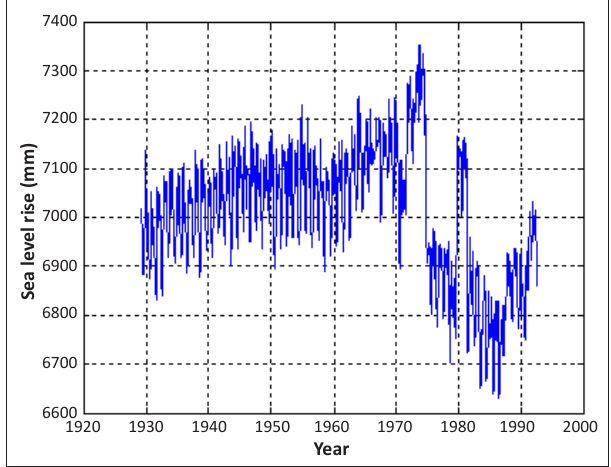
FIGURE 4: Plot of measured values of sea level data from